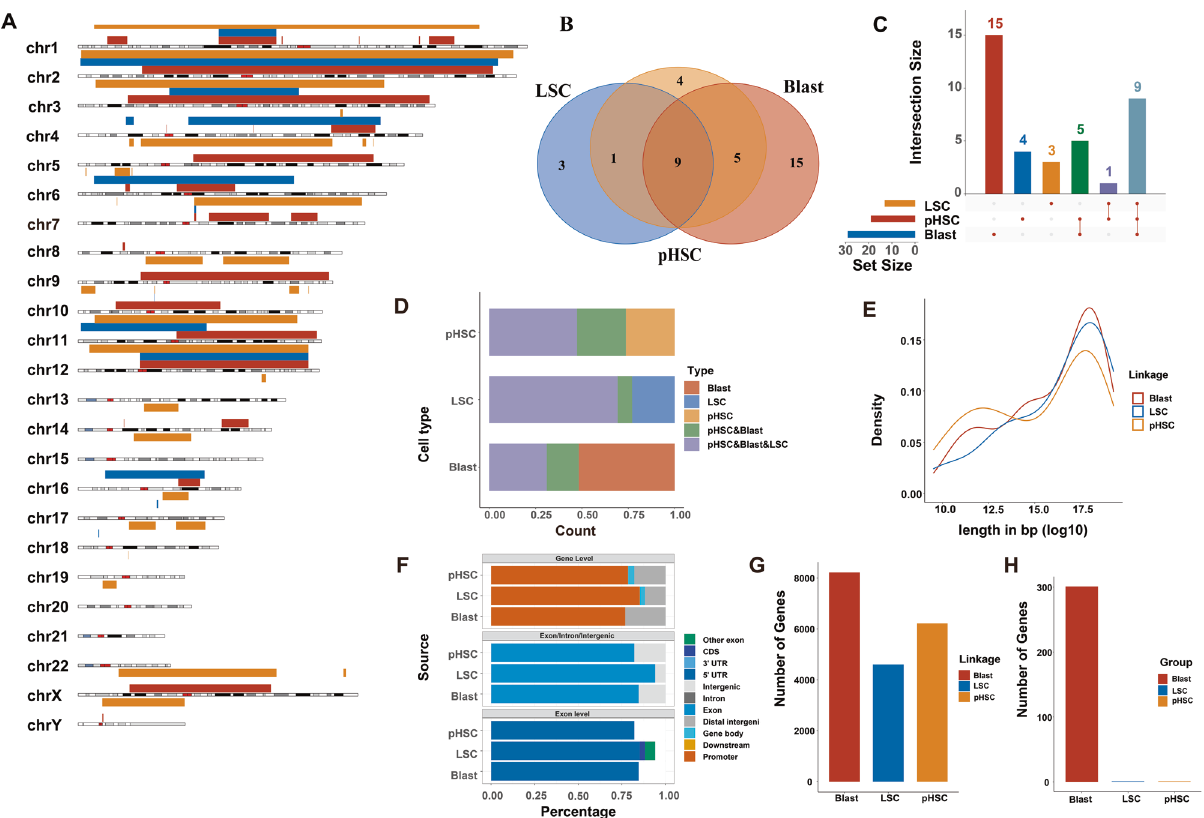
Fig. 6 ecDNA and ring chromosome in pHSC, LSC, and blast. A The distribution of ecDNA and ring chromosome across pHSC, LSC, and blast. B Venn diagram of overlapping ecDNA and ring chromosome. C The barplot showed the ecDNA and ring chromosome number in the overlap of different cells. D The frequency of overlapping ecDNA and ring chromosome in pHSC, LSC, and blast, respectively. E The length distribution of ecDNA and ring chromosome in pHSC, LSC, and blast. F Peak distribution over different genomic features. G The average number of genes on ecDNA and ring chromosome in pHSC, LSC, and blast. H The number of blast-speci fi c genes on eccDNA far more than pHSC and